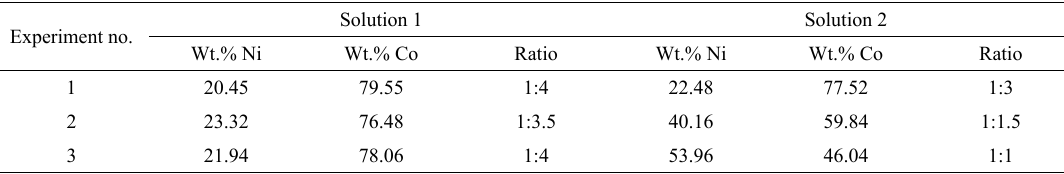
Table 2. EDS results for the coatings produced using Solutions 1 and 2 Experiment